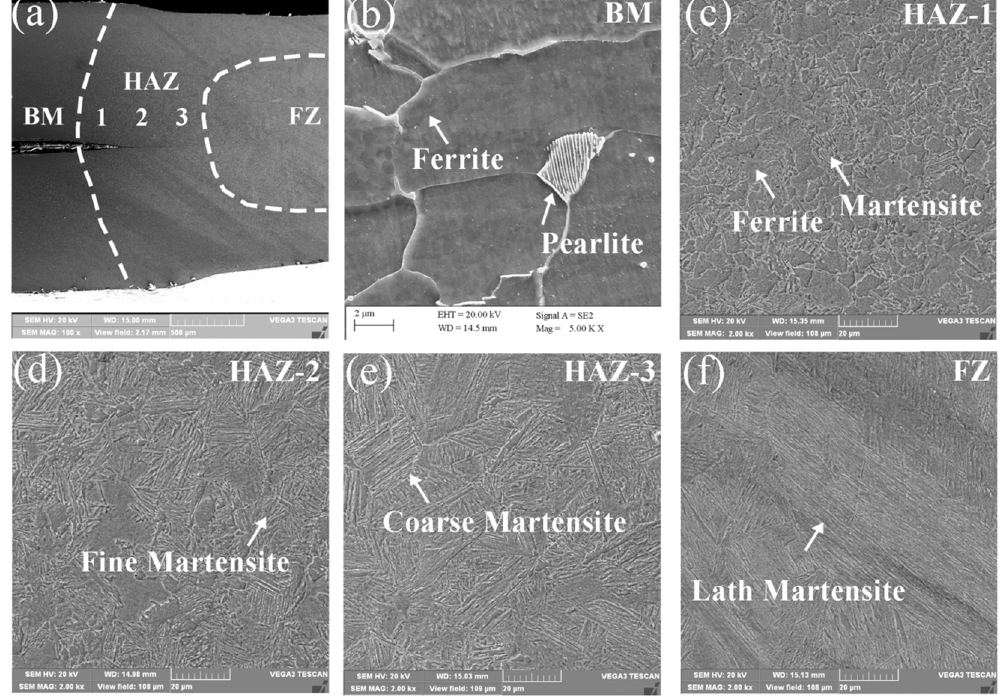
Figure 6: SEM images of welded joints ( 10 kA 16 cycles 2.2 kN ) : ( a ) 100X joints, ( b ) BM, ( c ) HAZ - 1, ( d ) HAZ - 2, and ( e ) HAZ - 3, ( f )